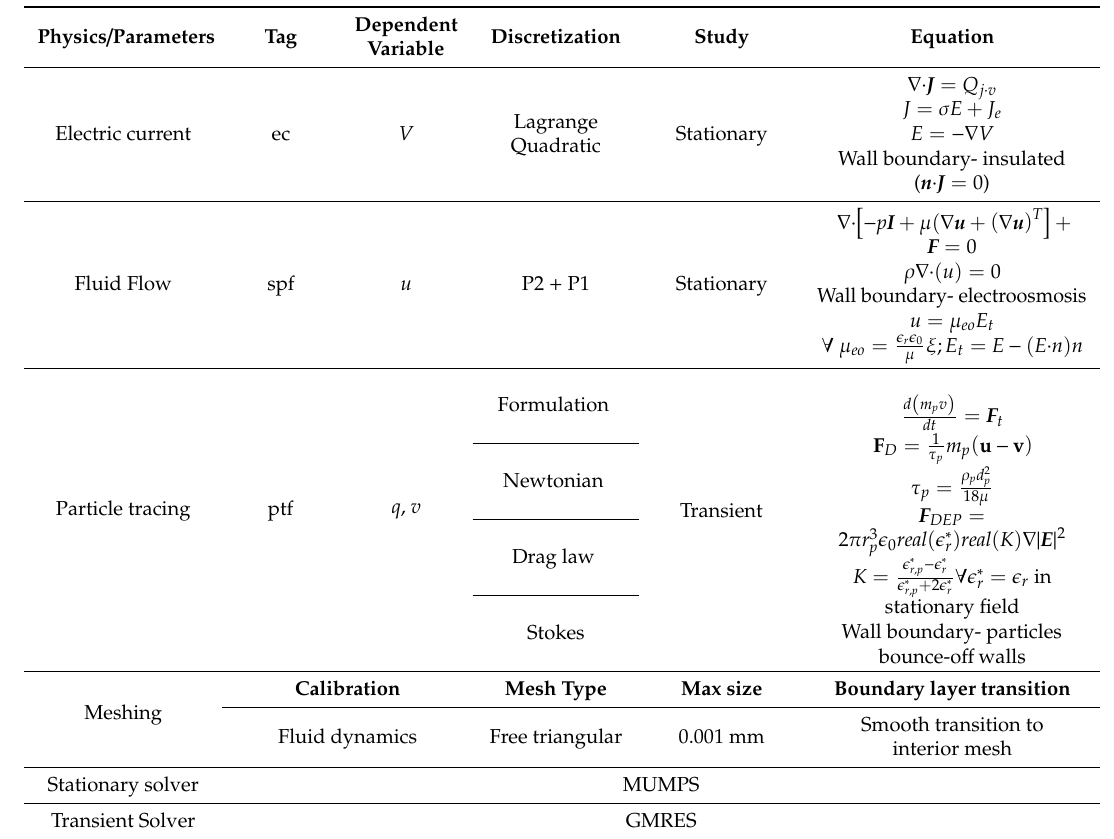
Table 1. List of parameters, variables, discretization, type of study utilized, and the equations associated that was incorporated into COMSOL package for optimizing the device geometry and sorting